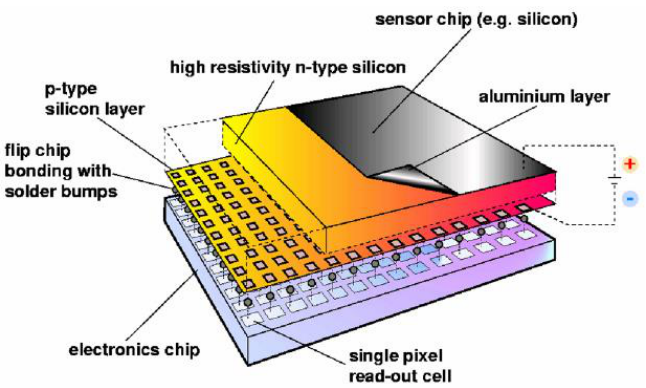
Figure 3. The Timepix chip with the standard silicon sensor on top. The GEMPix uses four ‘naked’ Timepix ASICs, i.e., without the silicon sensor chip (source: CERN).